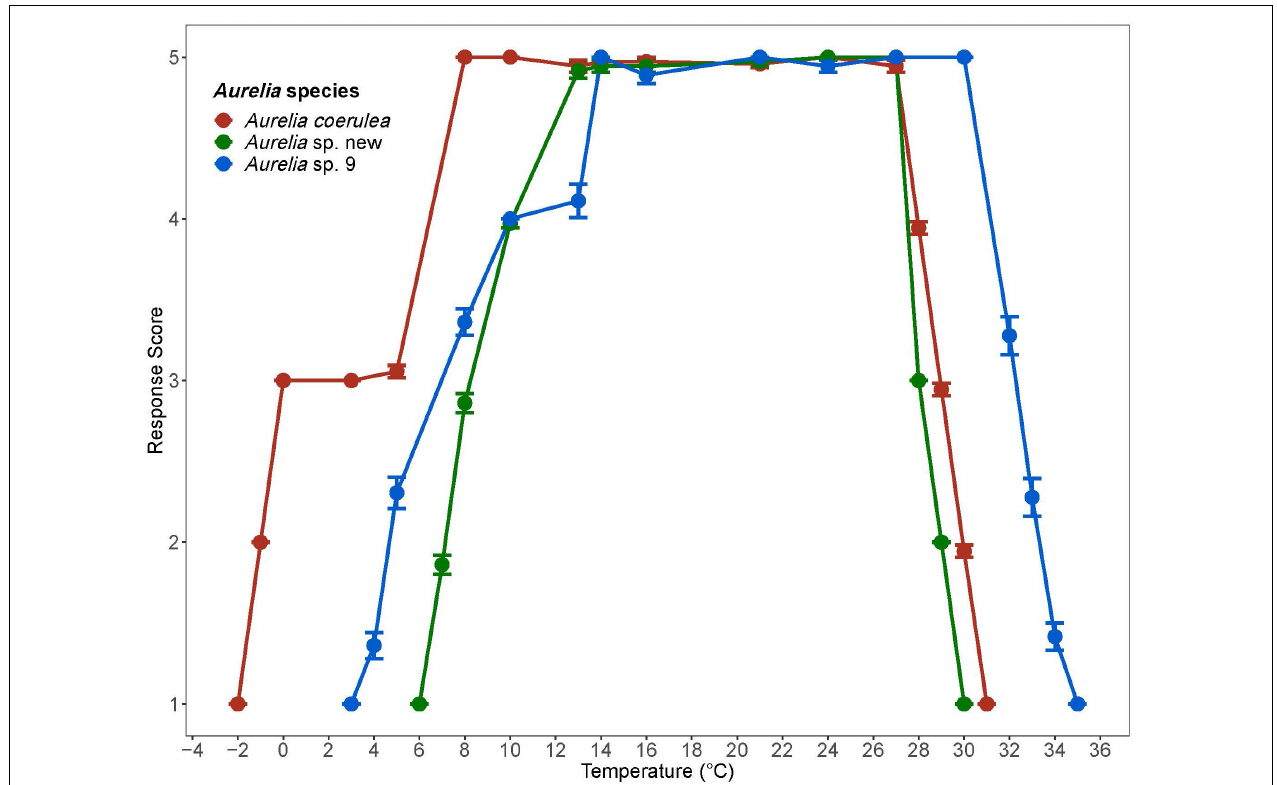
FIGURE 2 | Response scores of Aurelia species during 1 ◦ C/day temperature change. Response scores 1-5 are described in Table 1 . Temperature is in degrees Celsius ( ◦ C). Error bars display standard error. Colors correspond to Aurelia species: red is Aurelia coerulea , green is A. sp. new, and blue is A. sp. 9.